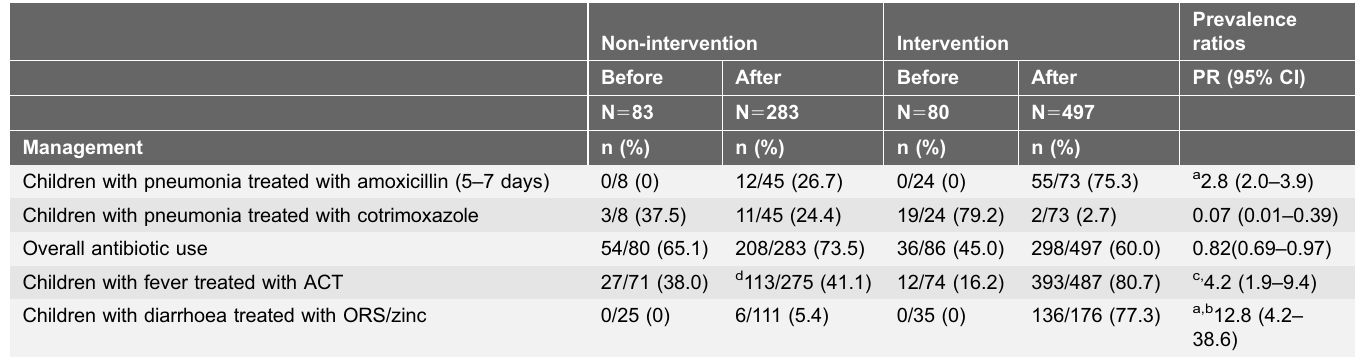
Table 3. The effect of the intervention on treatment using antibiotics, ACTs and ORS/zinc, by survey-adjusted prevalence ratios using difference in difference analysis and generalized linear models.